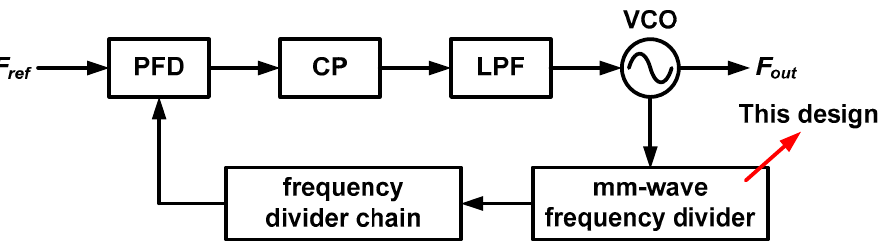
Figure 1. Conventional phase-locked loop with mm-Wave frequency divider.